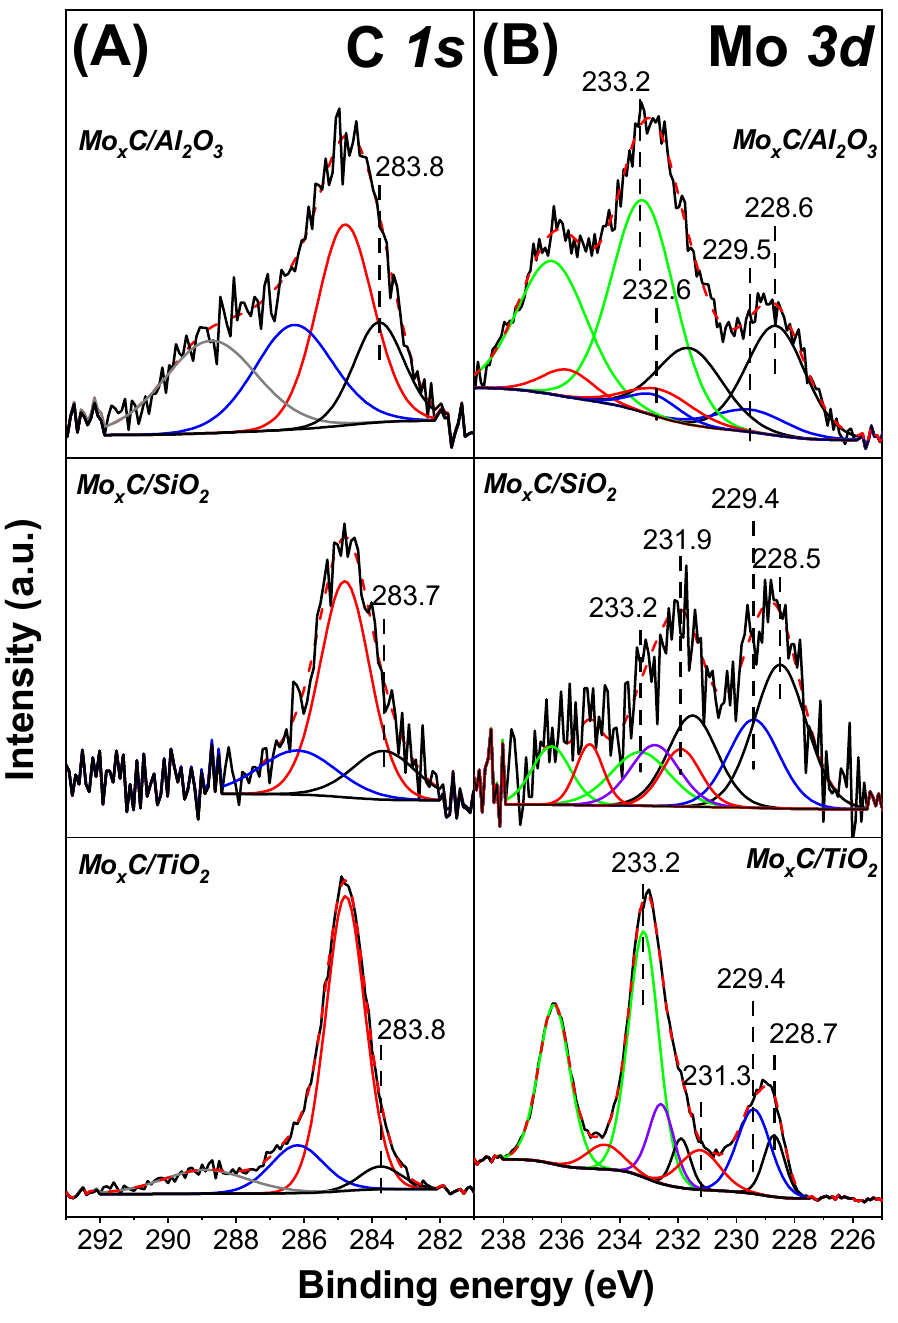
Figure 7. XP spectra of Mo x C/support catalysts: ( A ) C 1s level; ( B ) Mo 3d level.